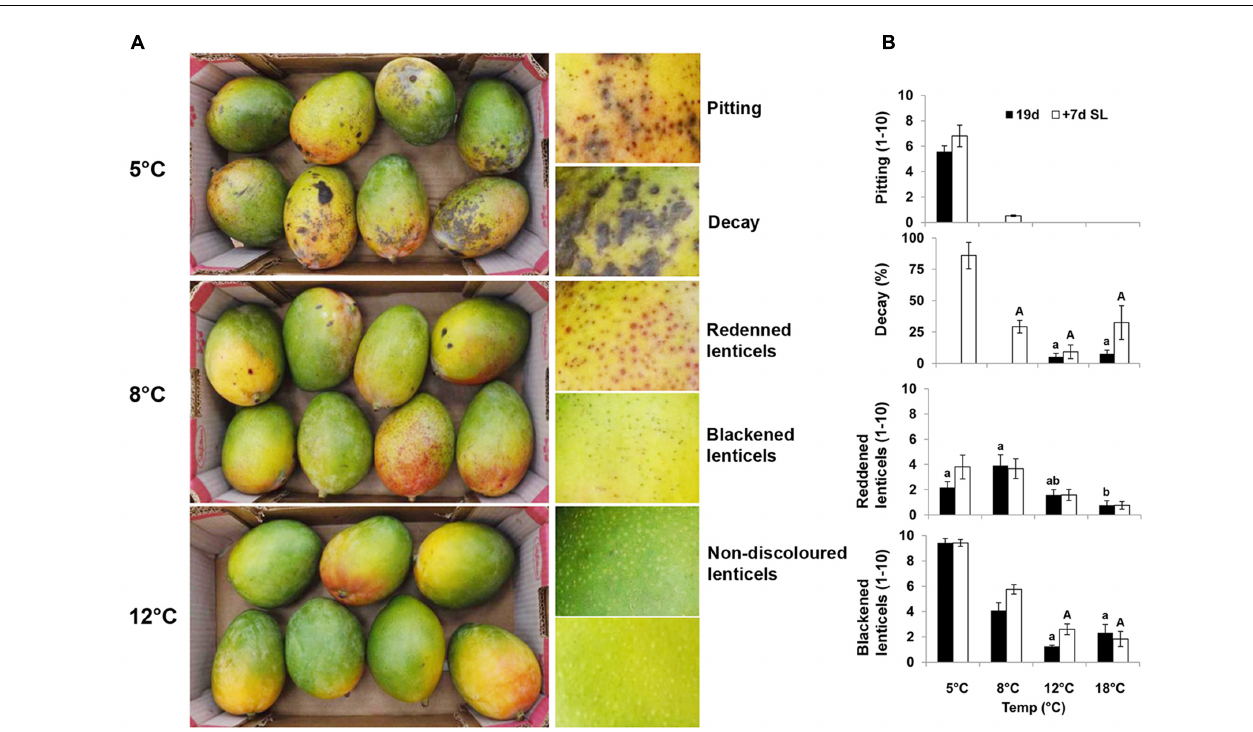
FIGURE 1 | ‘Keitt’ mango fruit chilling injury (CI) symptoms and their quantification. (A) Representative pictures of mango fruit showing CI symptoms after 19 days of cold storage at 5, 8, or 12 ◦ C. Fruit stored at 5 ◦ C show pitting and decay, at 8 ◦ C black spots and red spots, and at 12 ◦ C healthy tissue and lenticels. (B) Quantification of CI in mango fruit at various cold-storage temperatures (18, 12, 8, or 5 ◦ C) for 19 days (black column) and further shelf-life storage at 20 ◦ C for 7 days (white column). Red spots, black spots and pitting were evaluated on a scale of 1–10, and total decay in percentage. Data shown are mean ± SE of six biological replicates. Letters represent significant difference by one-way